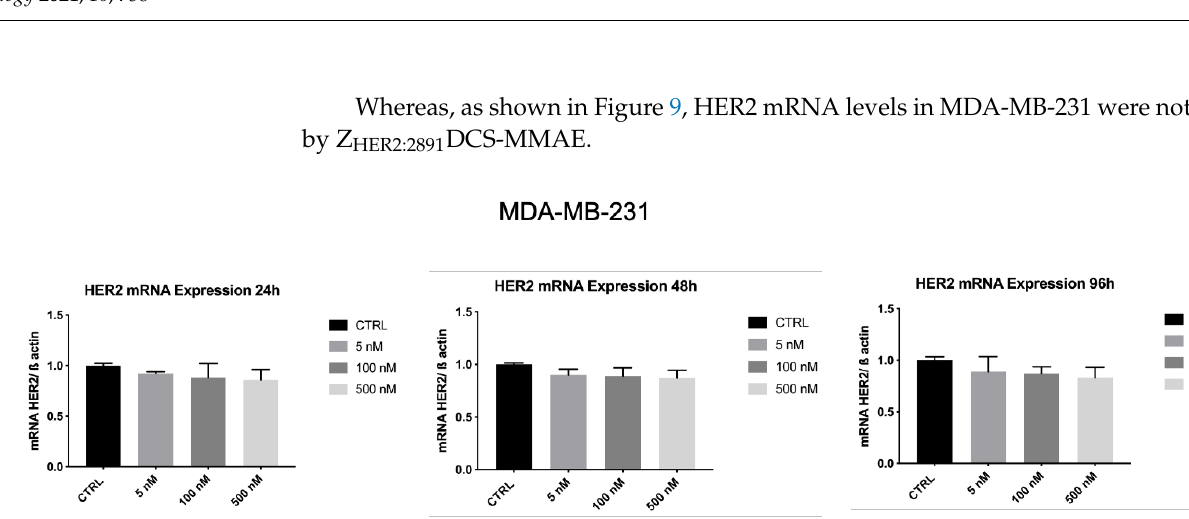
Figure 9. Effect of Z HER2:2891 DCS-MMAE on HER2 expression in MDA-MB-231cells. Cells were treated for 24, 48, and 96 h. The one-way ANOVA test did not reveal statistically significant differences between the control and treatments. Data are presented as mean ± SEM.